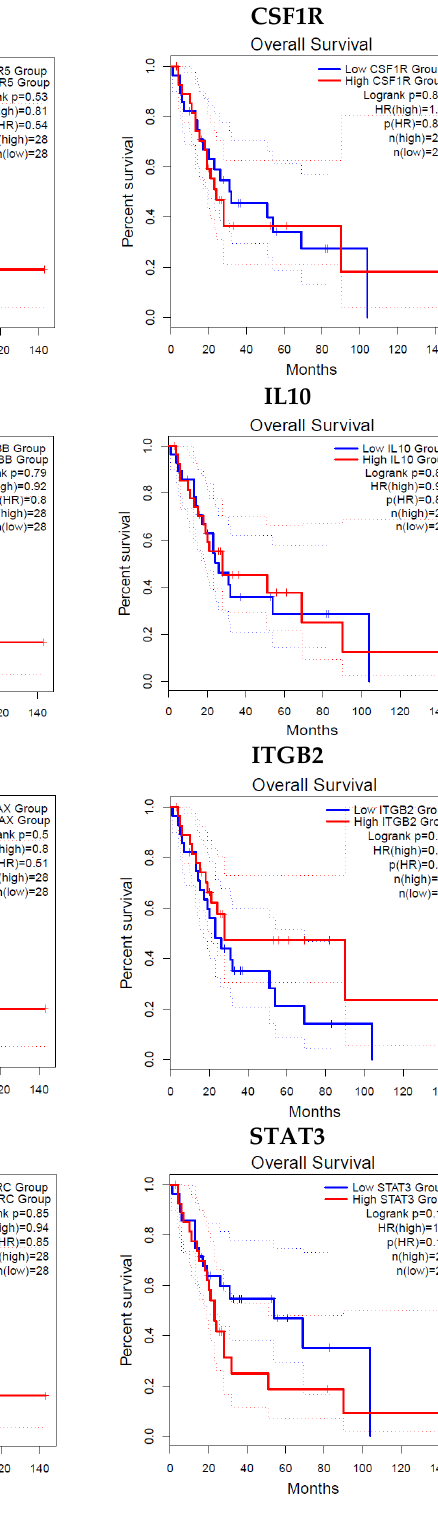
Figure 8. Kaplan–Meier overall survival analysis of the hub genes expressed in CC. Curves were generated using Gene Expression Profiling Interactive Analysis based on The Cancer Genome Atlas database ( p ≤